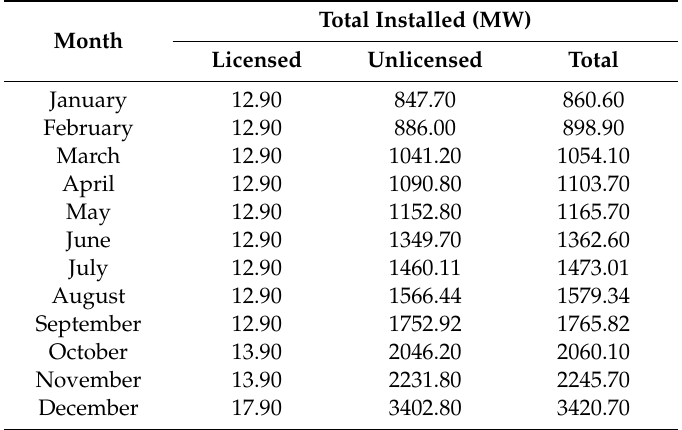
Table 2. Installed Photovoltaic (PV) Power Data from [25] in Turkey (2017).